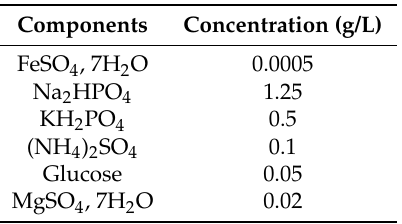
Table 2. Composition of the biofilm nutrient